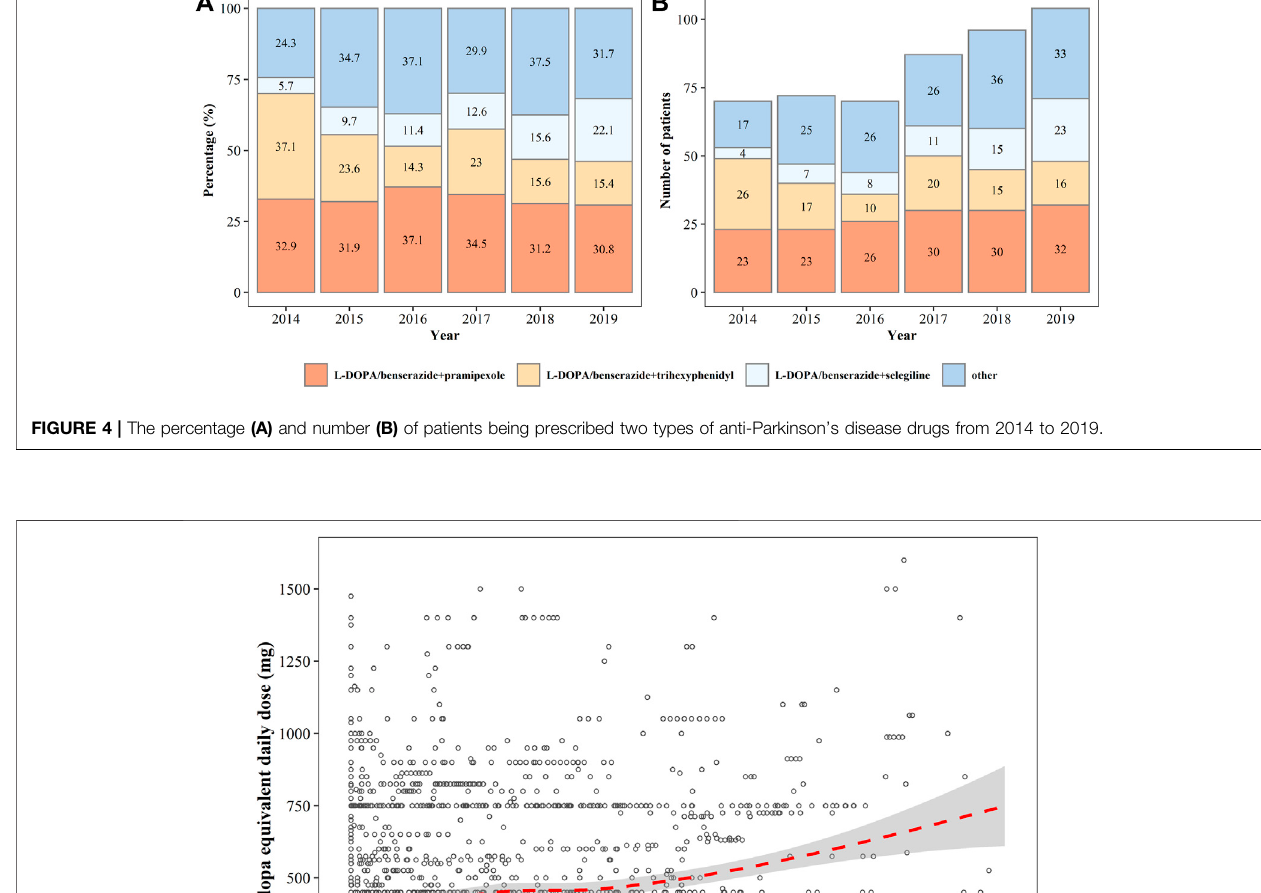
Frontiers in Pharmacology |